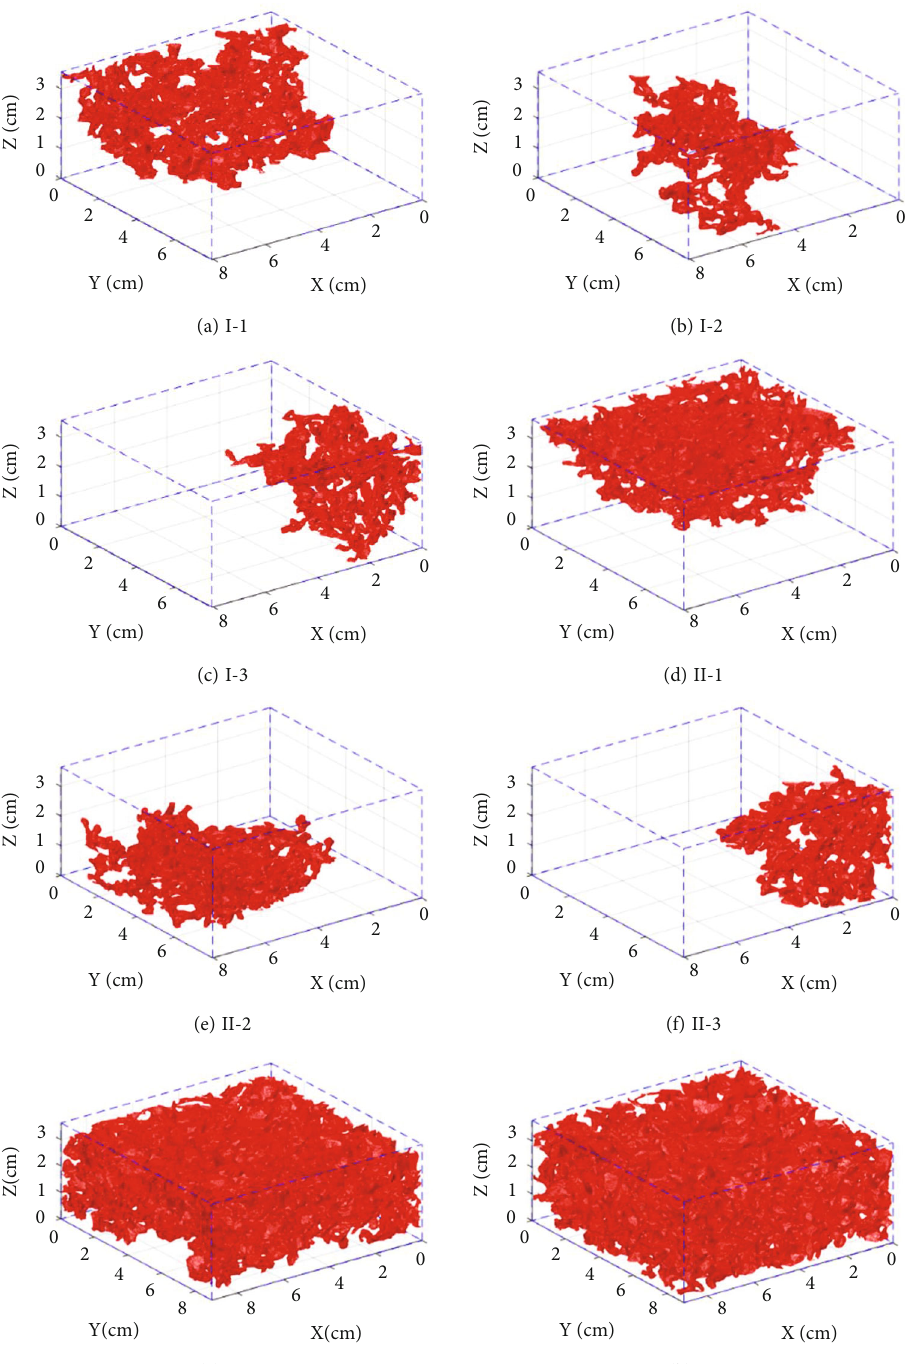
Figure 4: Interconnected pore